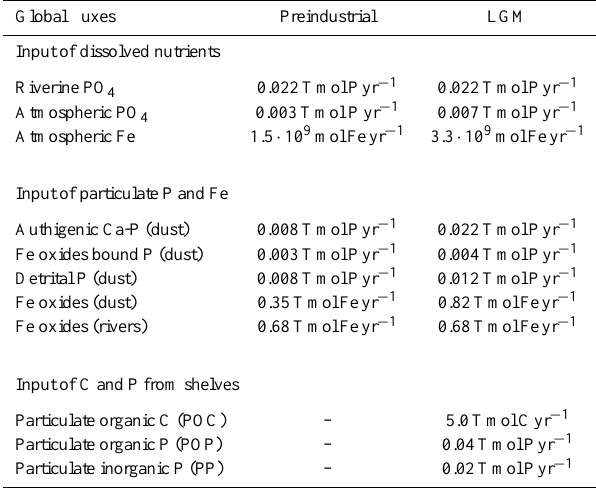
Table 1. Global fluxes of nutrients and particulate material in the preindustrial run (reference case) and the LGM